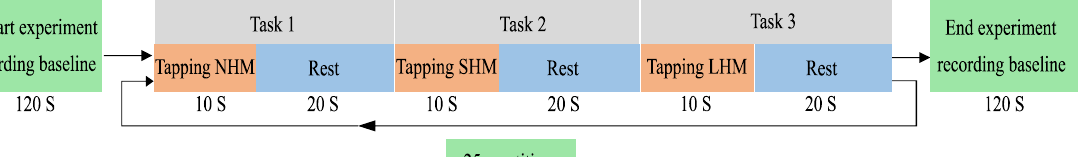
Figure 3. The experimental procedure and sequence of the tasks. The participants first performed hand tapping without head movements for 10 s (NHM), then, after a 20 s rest period, hand tapping with small head movements (SHM) for 10 s, and, after a 20 s rest period, hand tapping with large head movements (LHM) for 10 s, followed by a 20 s rest period. This sequence was repeated 25 times. A baseline was recorded at the beginning and the end of the experiment.